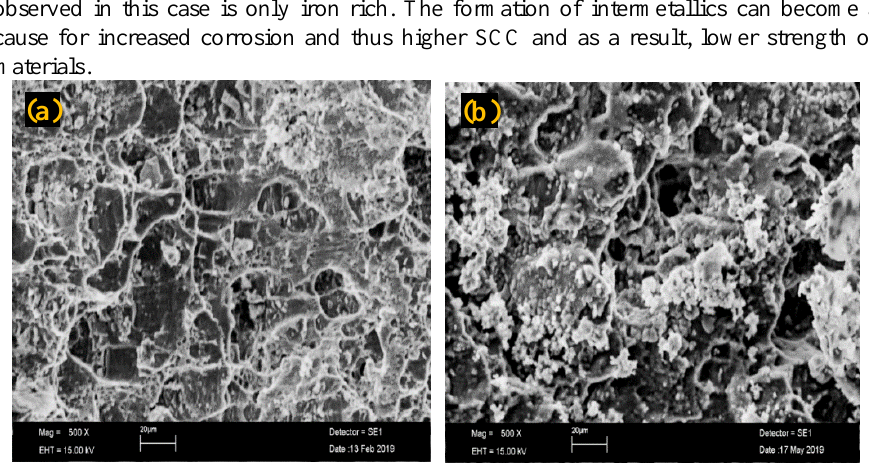
Fig. 10. SEM of rolled & 50°C annealed after SCC